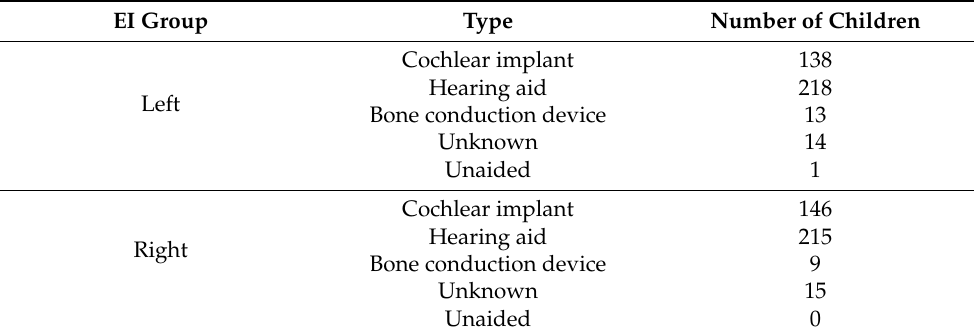
Table 4. Early Intervention (EI) group by device used (bilateral hearing loss).